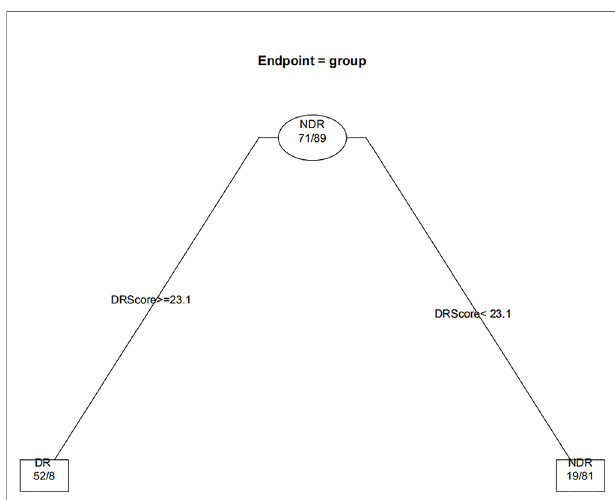
FIGURE 6 | Decision tree for detecting DR using only DR score.